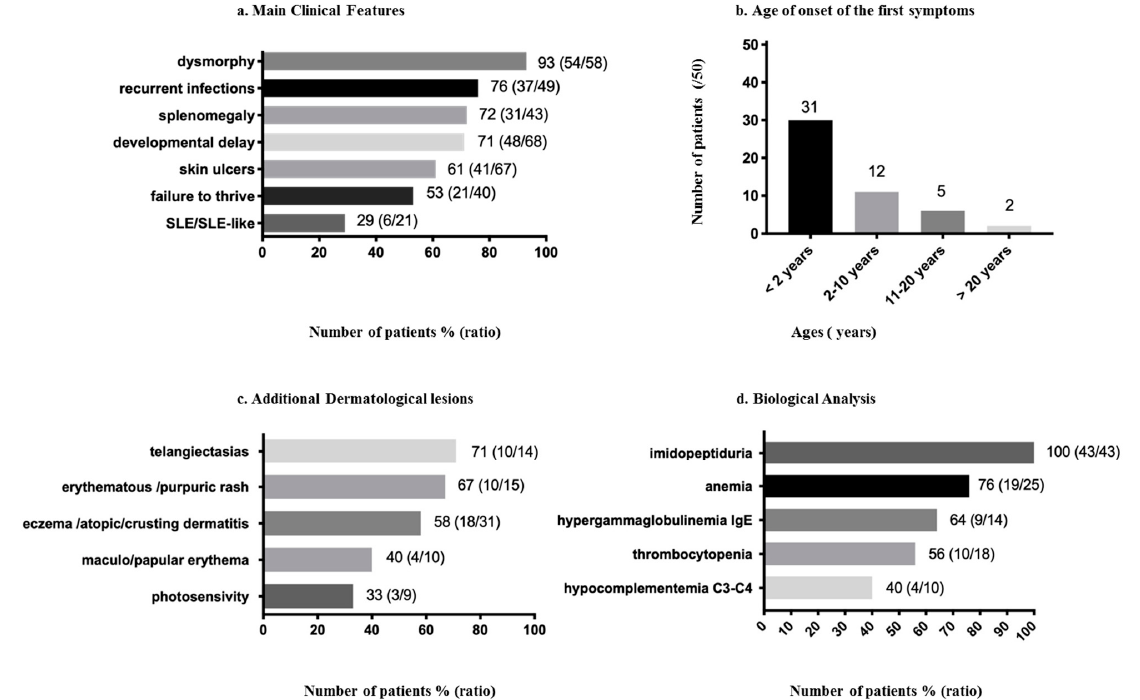
Figure 1. Clinical and biological features reported in prolidase deficiency (PD) patients 1. ( a ) Main clinical features of PD patients. ( b ) Age of onset of the first symptoms. ( c ) Other dermatological lesions. ( d ) Biological analysis.